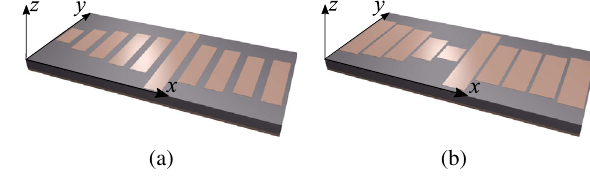
FIG. 9. Schematic representation of a single unit cell of a designed (a) three-channel power splitter and (b) five-channel